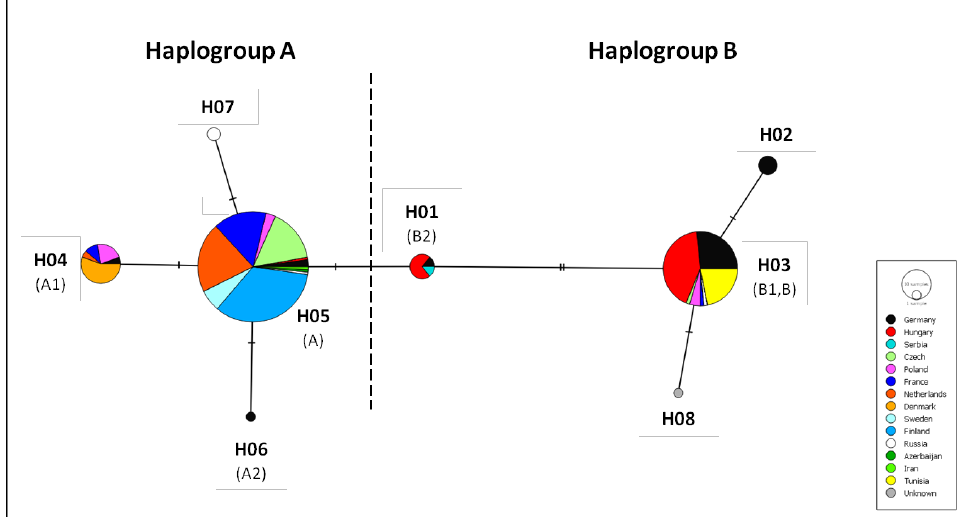
Figure 5. Median-joining haplotype network for cyt b (571 bp) of pikeperch ( Sander lucioperca ). Each disc represents a haplotype, and its size is proportional to haplotype frequency. Colors indicate geographic origin. In parentheses are the original names of haplotypes described by Kohlman et al. [13]. The dashed line delimits the two haplogroups based on the analysis of the complete cyt b